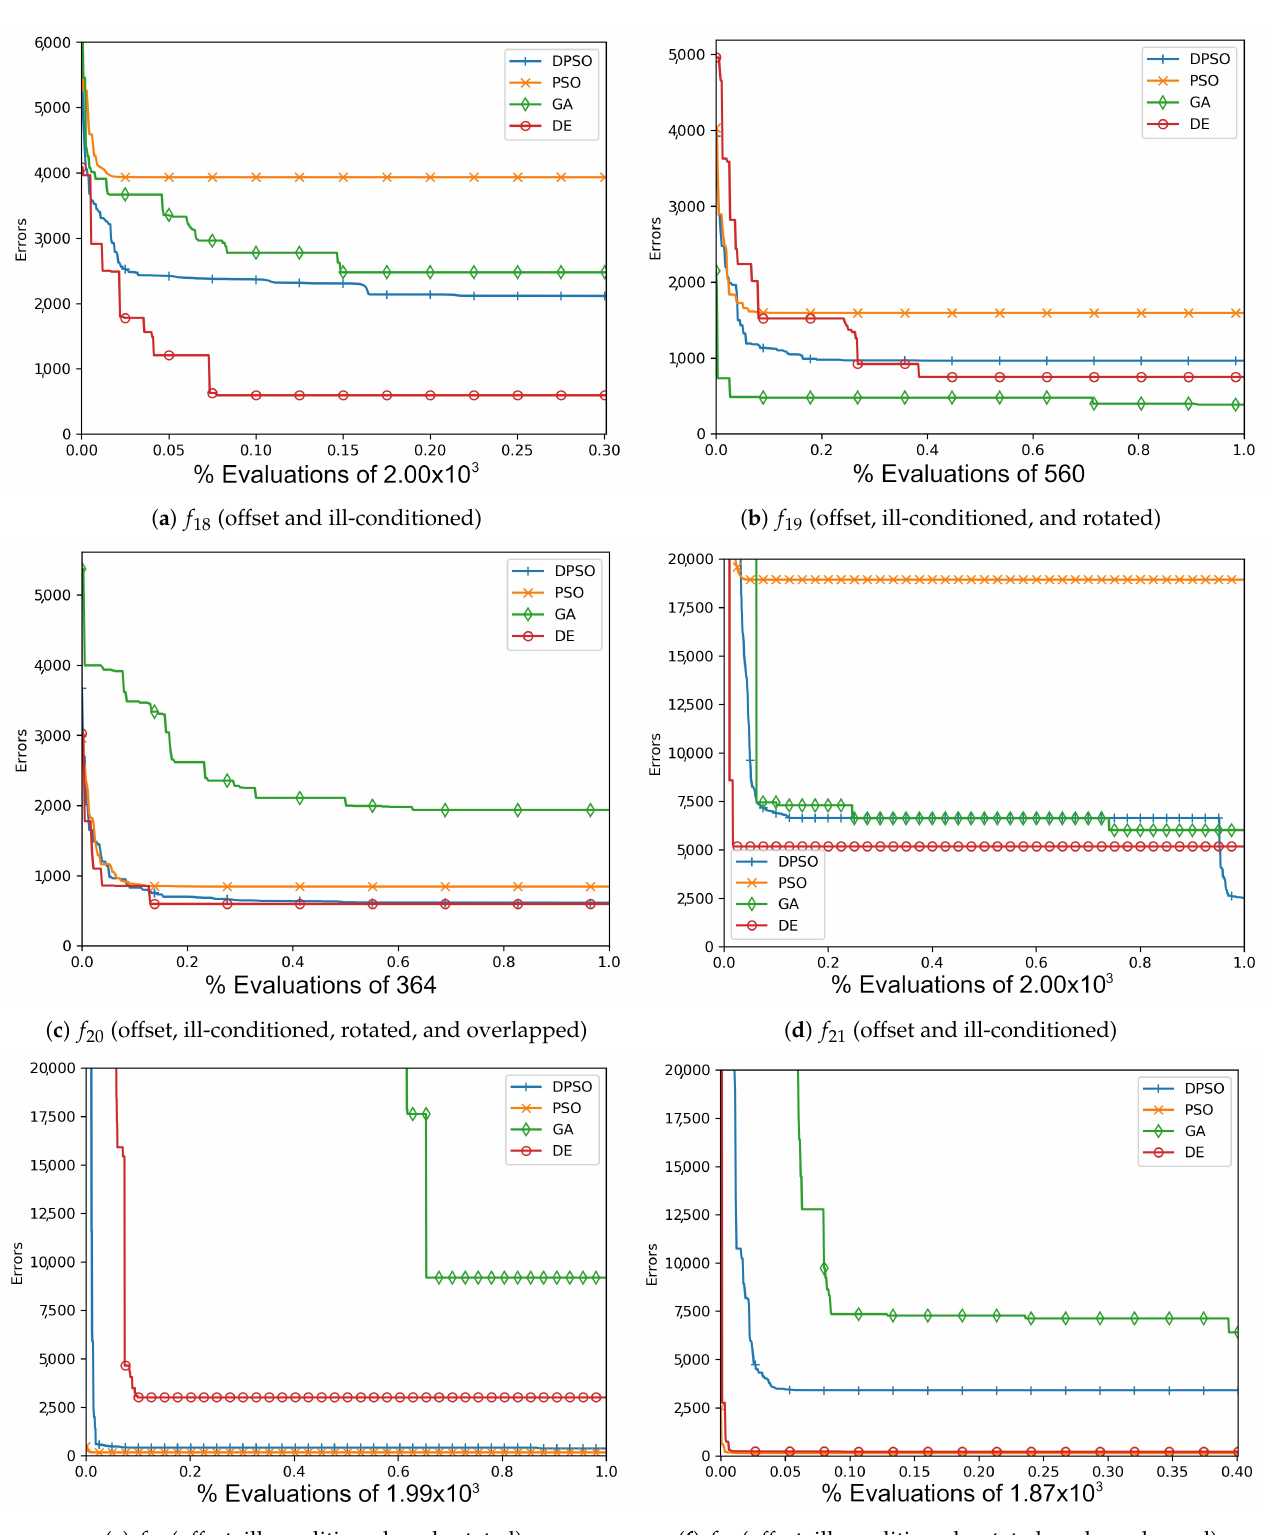
Figure A12. The average Zero-Sum ( f 18 , f 19 , f 20 ) and Salomon ( f 21 , f 22 , f 23 ) global best results over time for 21